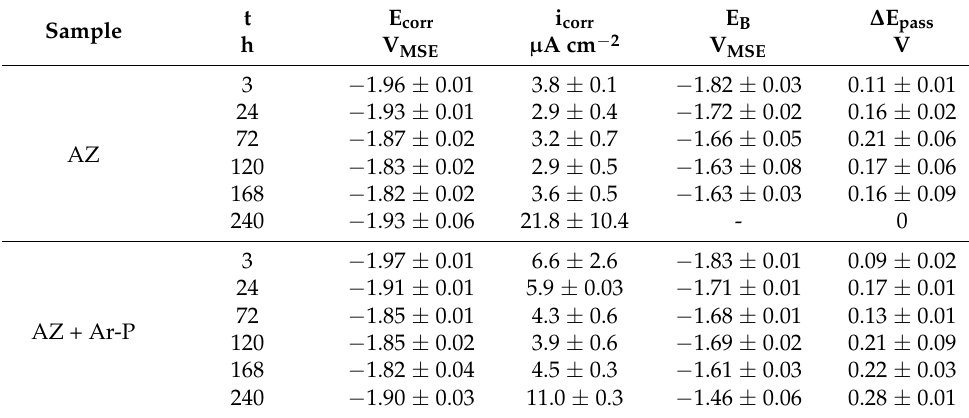
Table 2. Electrochemical parameters of AZ31 alloy in Na 2 SO 4 0.1 M.